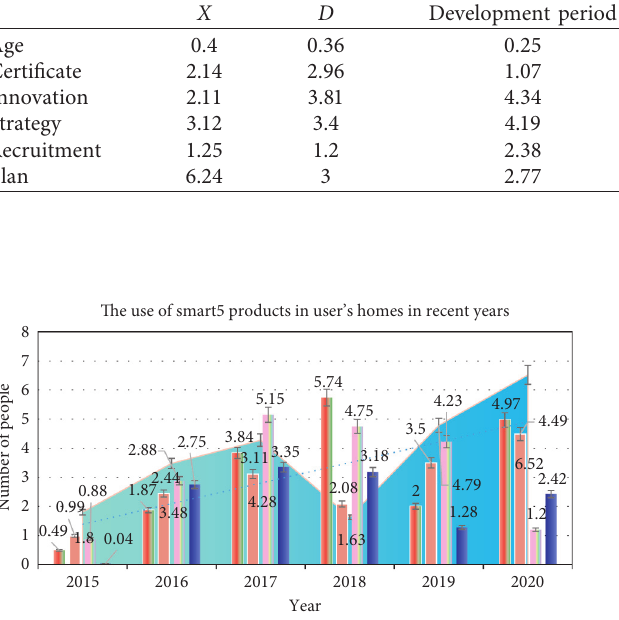
Table 11: The influence of staff management and member quality on company benefit. X